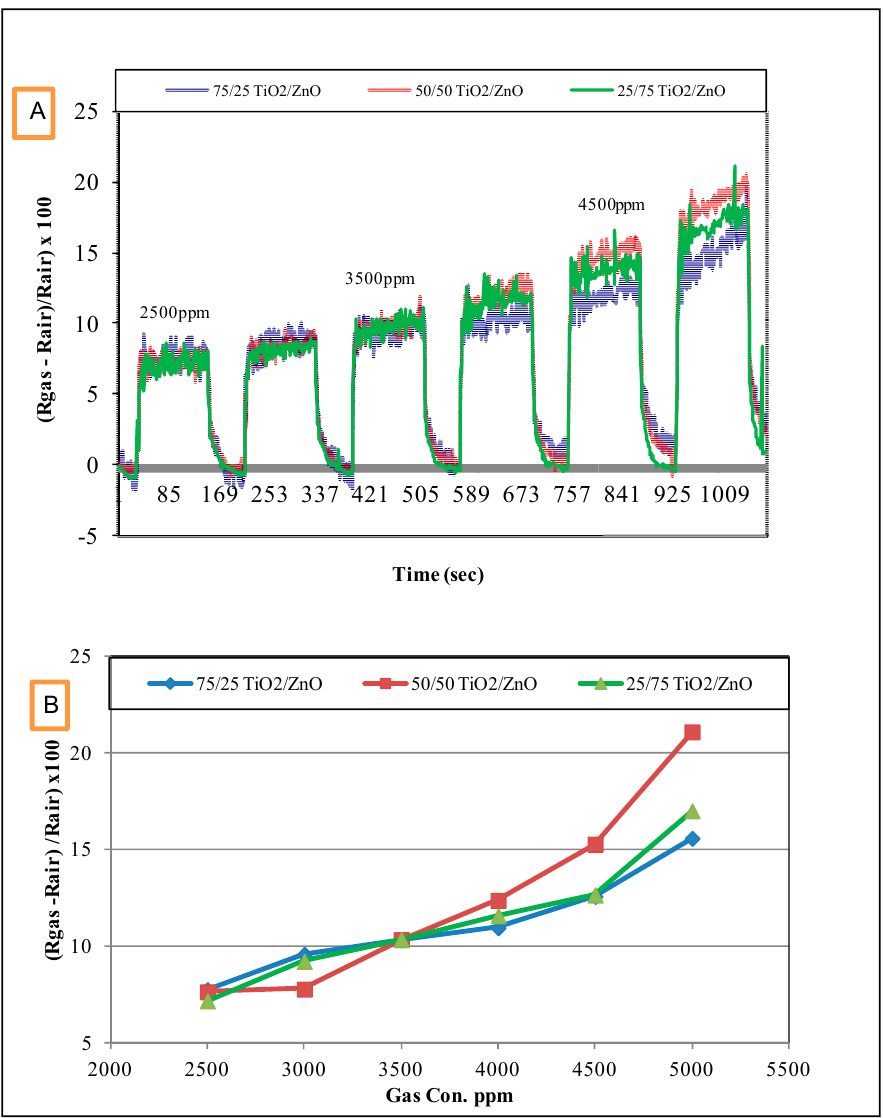
Figure 6. The response of the Zn 2 TiO 4 sensors to propanol at a concentration range of 2500–5000 ppm at room temperature. ( A ) The response of the sensors with time (Sec.) and ( B ) The response of the sensors with gas concentration (ppm).